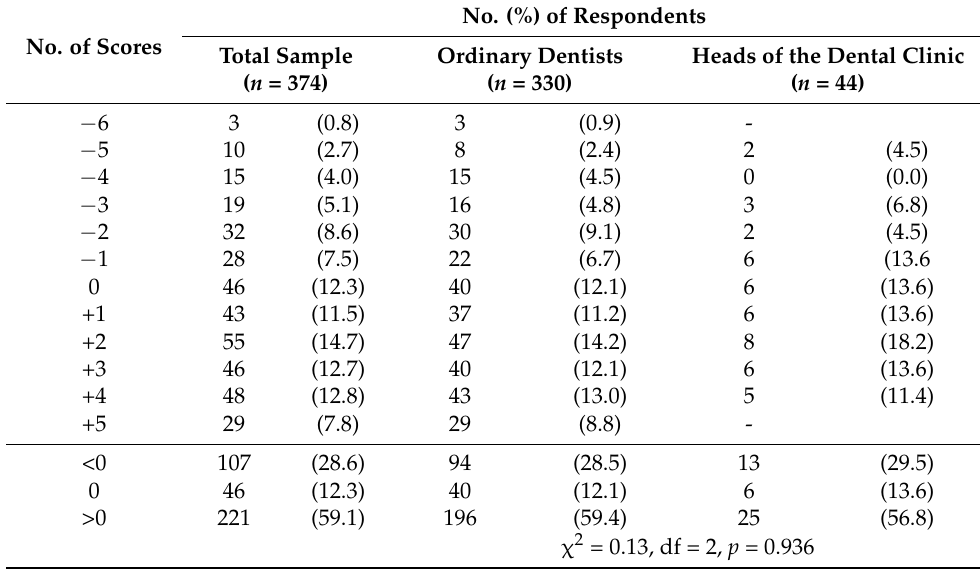
Table 3. Frequency of job satisfaction scores in studied